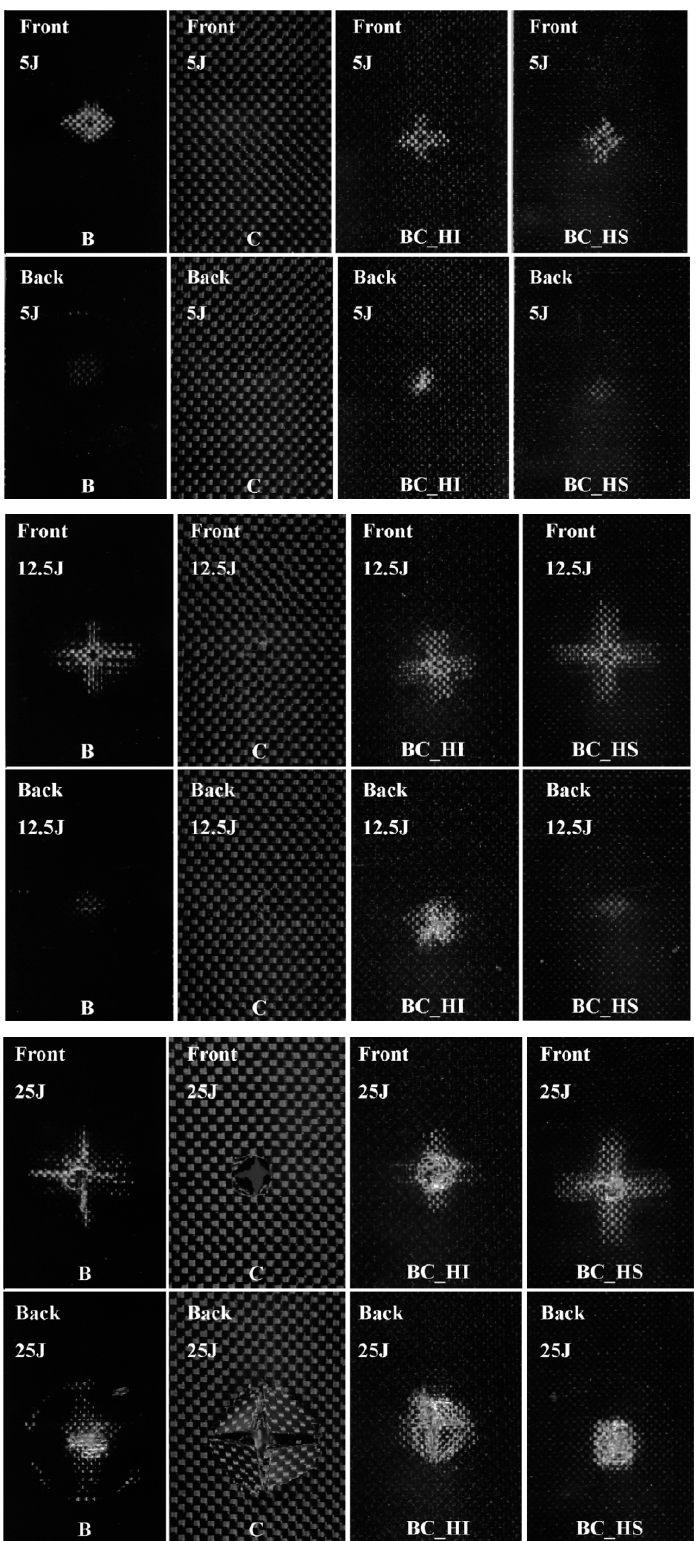
Figure 8. The sandwich and intercalated carbon–basalt hybrid laminates compared with pure carbon and pure basalt laminates at different impact energies (from the original supplied by the authors of [18]).